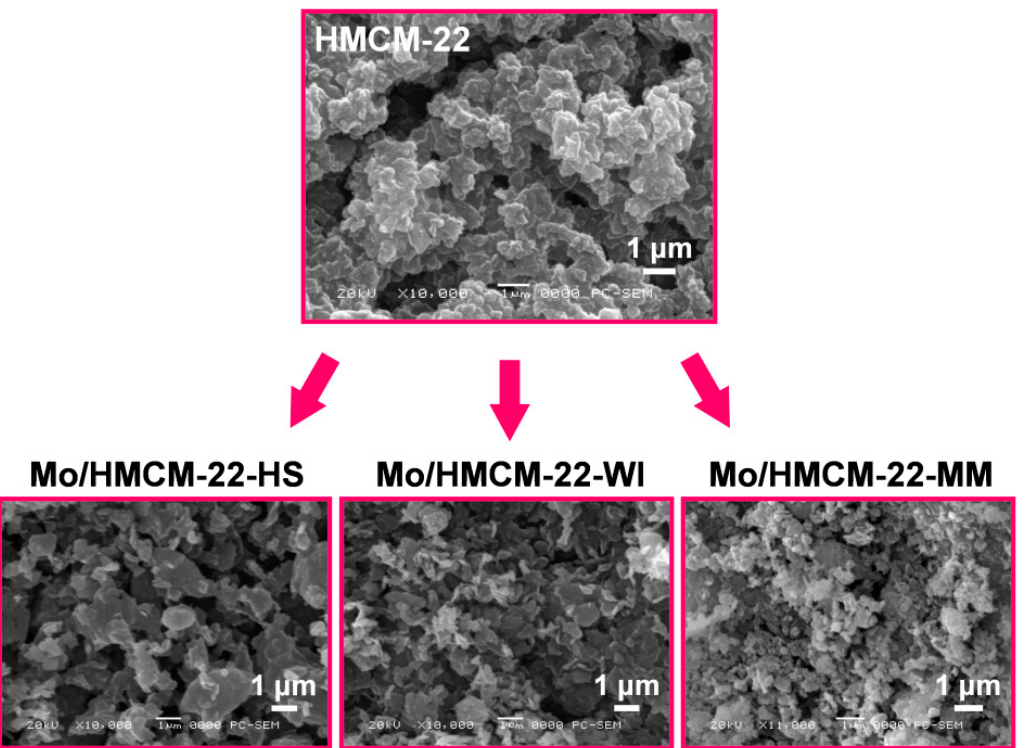
Figure 3. Scanning electron microscopy (SEM) images for the HMCM-22 zeolite and Mo/HMCM-22 catalysts. (top) HMCM-22 zeolite, (bottom left) Mo/HMCM-22-HS, (bottom center) Mo/HMCM-22-WI, and (bottom right) Mo/HMCM-22-MM.